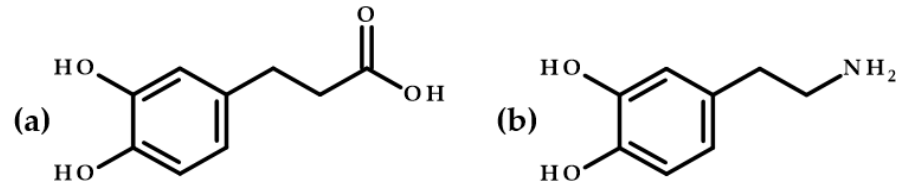
Figure 1. Chemical structures of ( a ) dihydrocaffeic acid and ( b ) dopamine.